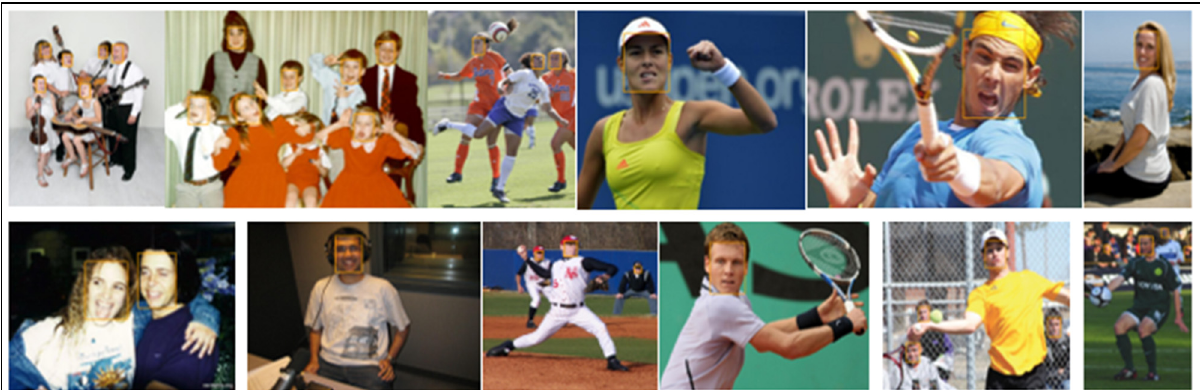
Figure 3. Expression image results (WIDER FACE dataset).